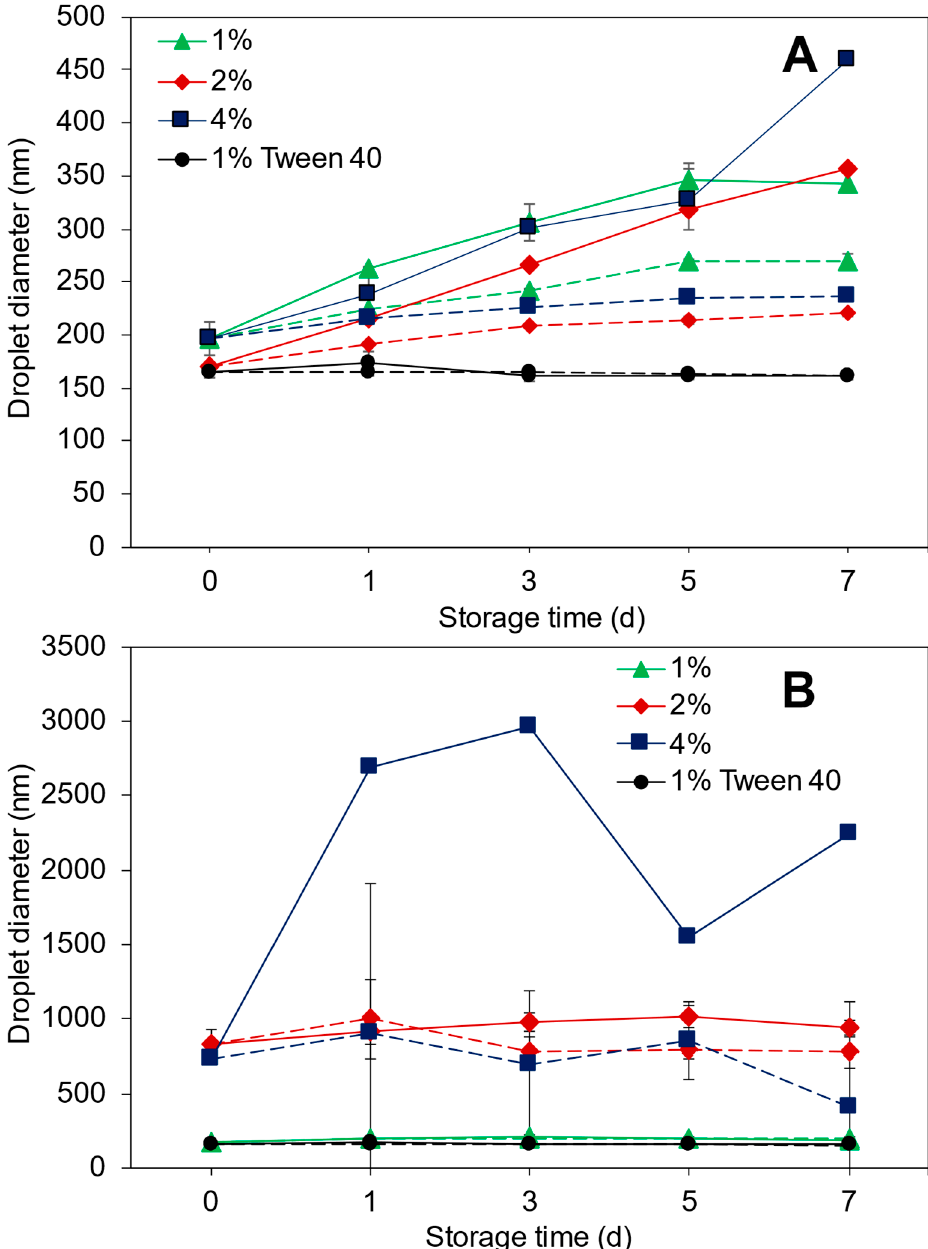
Figure 2. Storage temperature (4 and 25 °C) and time (0–7 d) on the droplet diameters of UC–10F chymotrypsin ( A ) and UP–10F pepsin ( B ) (nano)emulsions at varying emulsifier concentrations (1–4%). Legend: 4 °C, broken lines; 25 °C, solid lines; and 1% Tween 40, black lines. Irrespective of the peptide fraction, enhanced stability occurred at lower peptide nanoemulsion, especially at 25 °C but was unchanged for the 1% UP–10F nanoemulsion concentrations and storage temperature (Figures 2 and 3). With increasing peptide